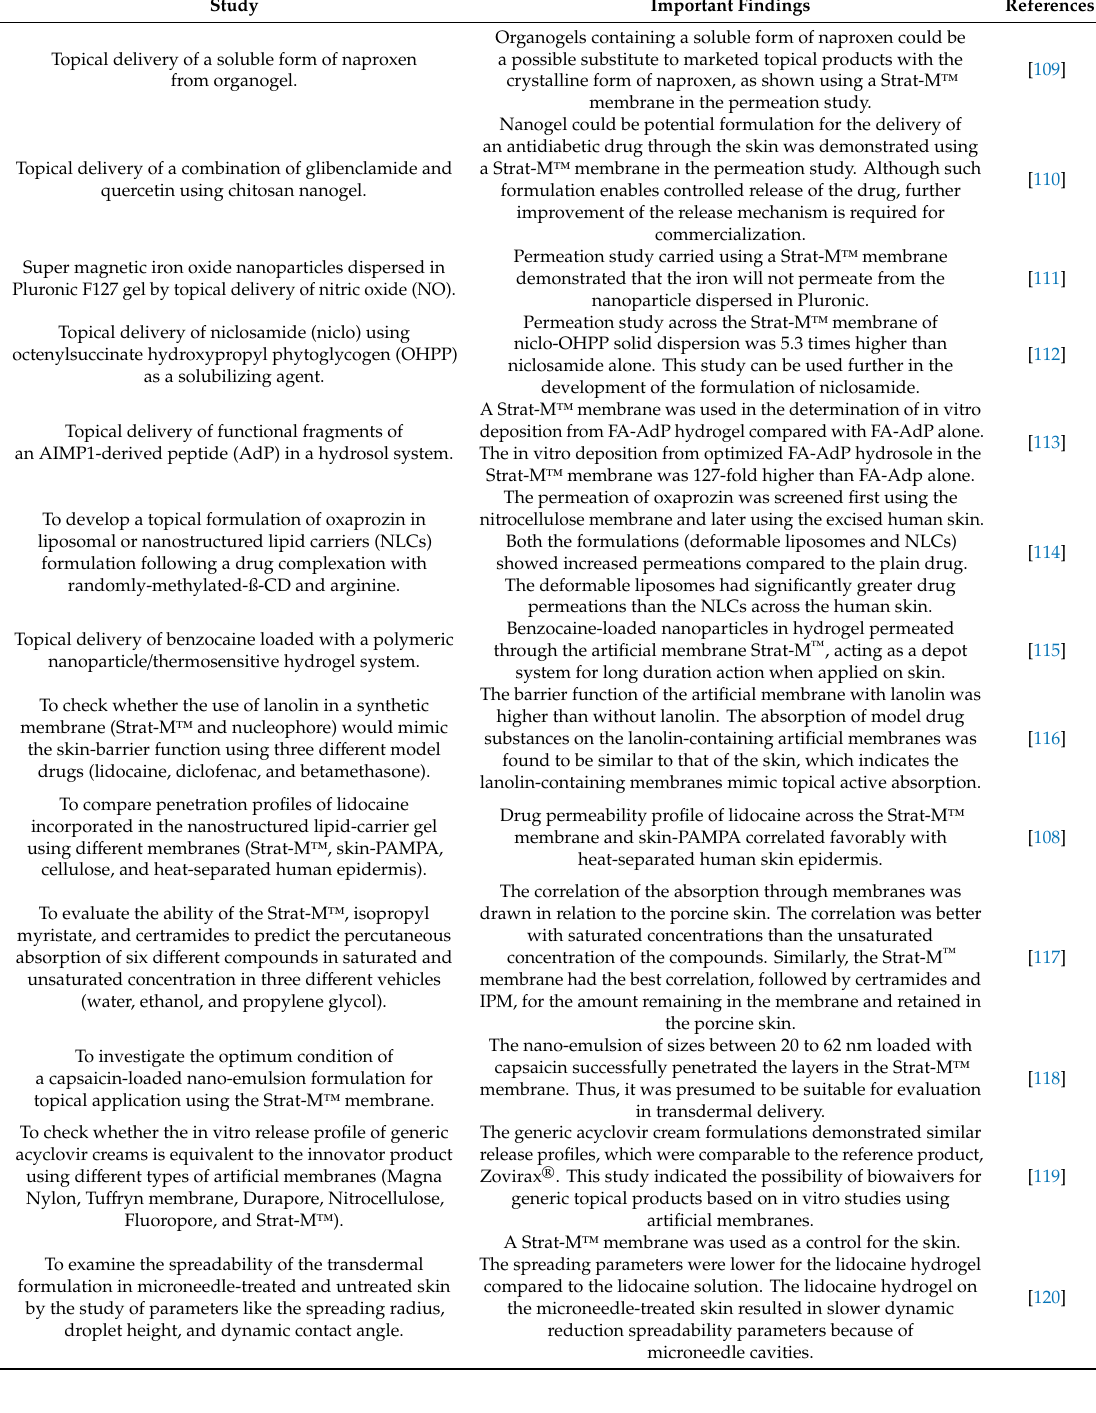
Table 2. Recent studies involving the use of synthetic membranes in permeation studies (partial